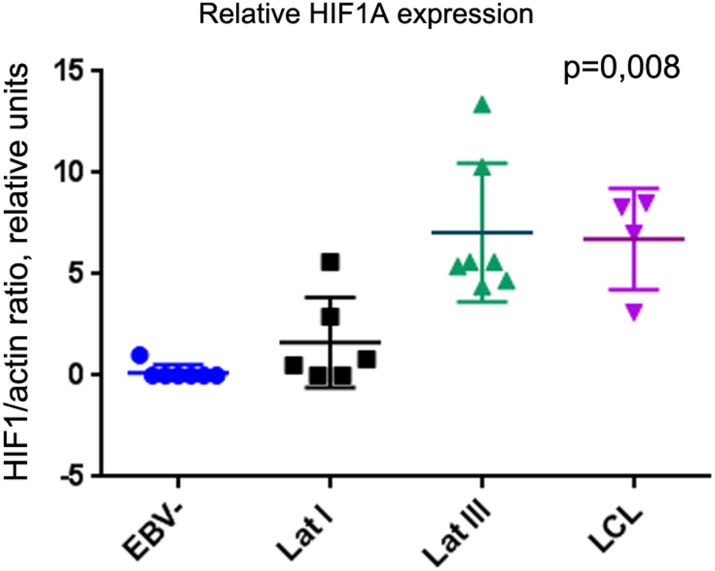
Statistical analysis of relative HF1A protein expression.Kruskal–Wallis tests were applied to four groups, comprising seven EBV-negative, six Latency I, seven Latency III BL cell lines, and four LCLs. HIF1A was expressed significantly higher in Latency III cells (p = 0.008<0.05).